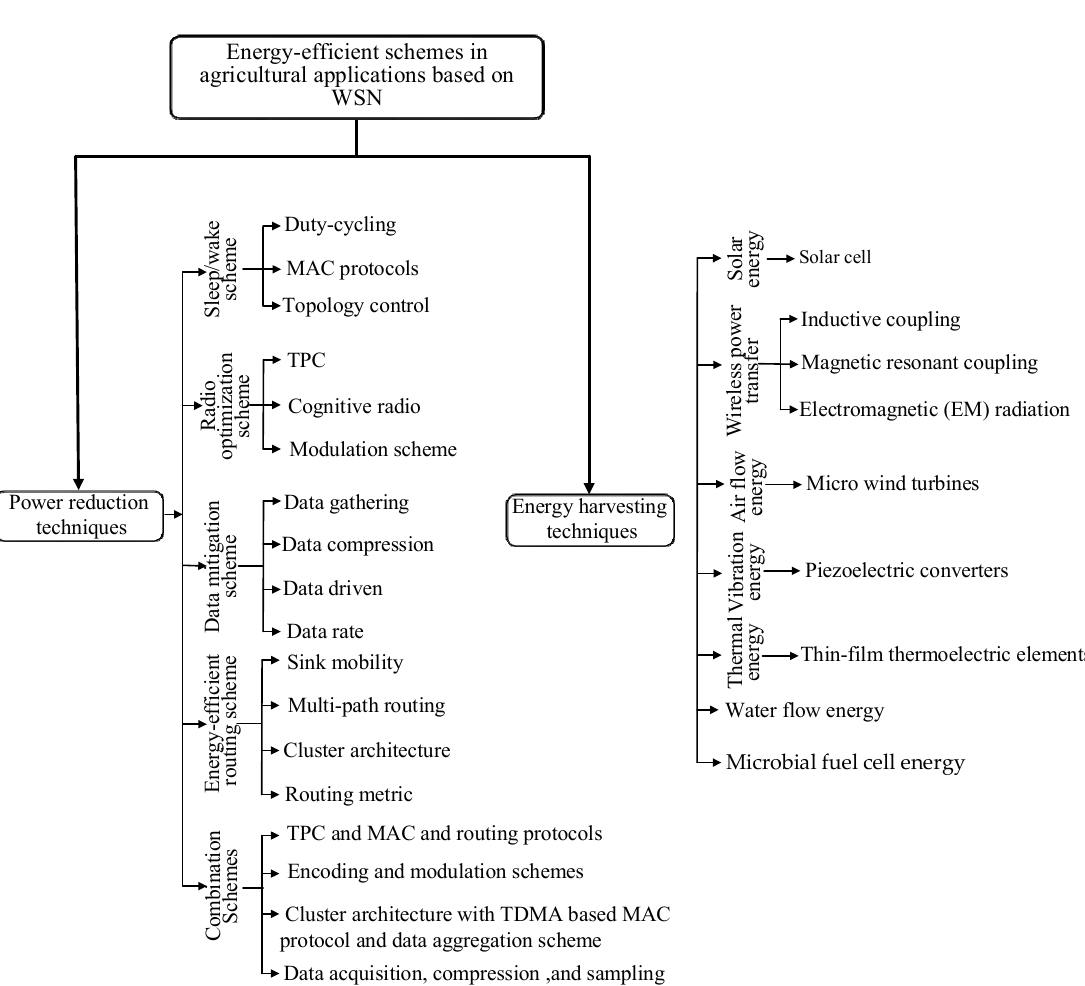
Figure 2. Energy-efficient schemes in agriculture based on wireless sensor networks (WSNs).